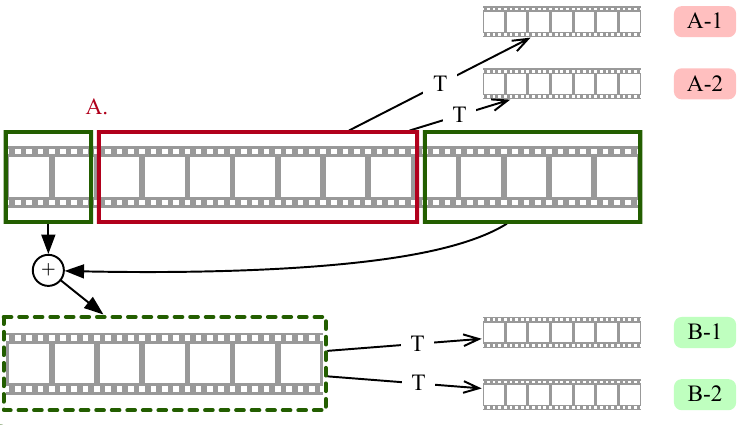
Figure 3. The contrastive subclips. Subclip ( A ) is a random half-length crop of the original sequence, and then we create subclip ( B ) by concatenating the remaining two pieces. T denotes a random instance of the video transform operations containing color distortion, Gaussian blur, and temporal padding. A-1 and A-2 are different subclips but express the same facial motion, and so are B-1 and